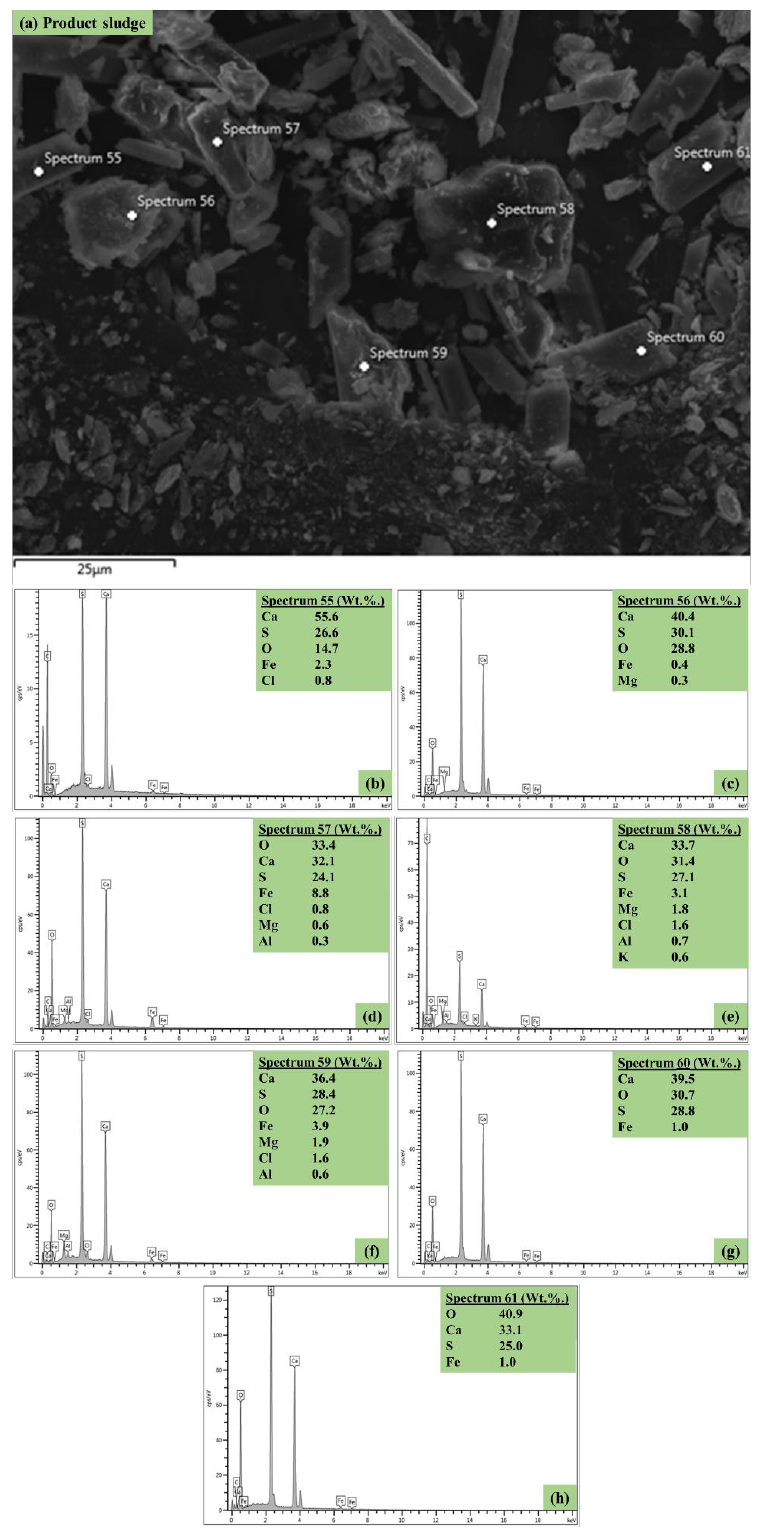
Figure 6. ( a – h ) : The HR-SEM-EDX morphological results showing: ( a ) the spot analysis image of the product sludge, and ( b – h ) the respective spot elemental compositions.